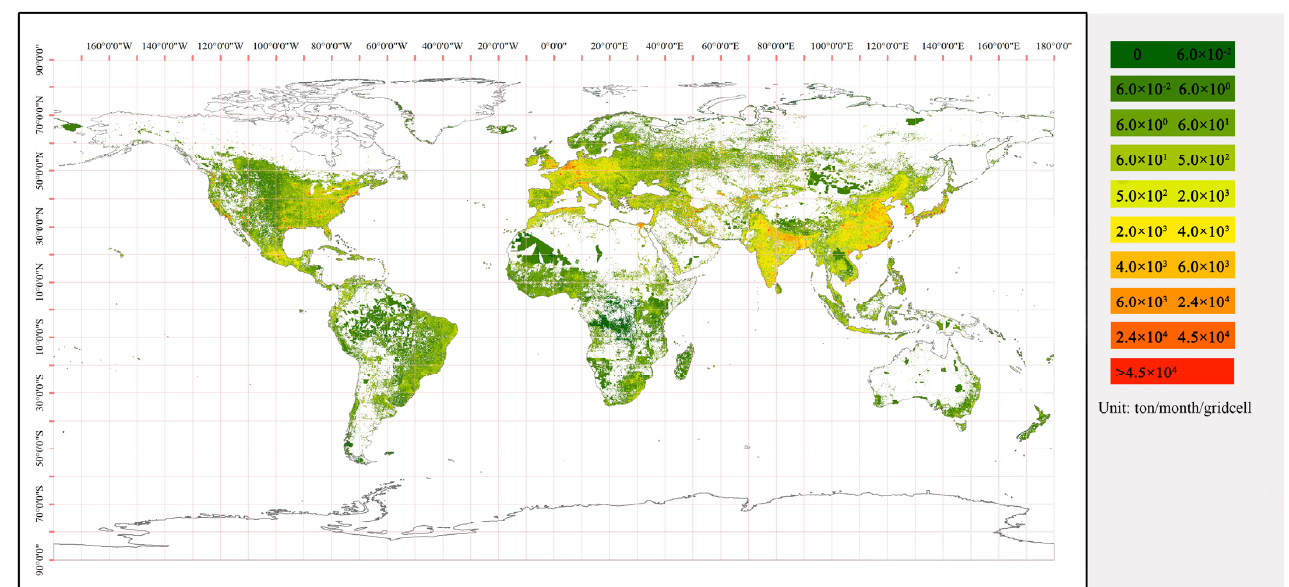
Figure 3. EDGAR gridded map of building-sector CO 2 emissions in January.